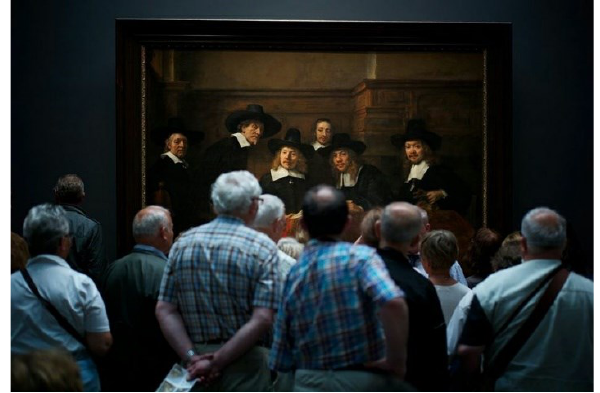
Figure 7: Other Generations Viewing the Rembrandt Painting 1981), the